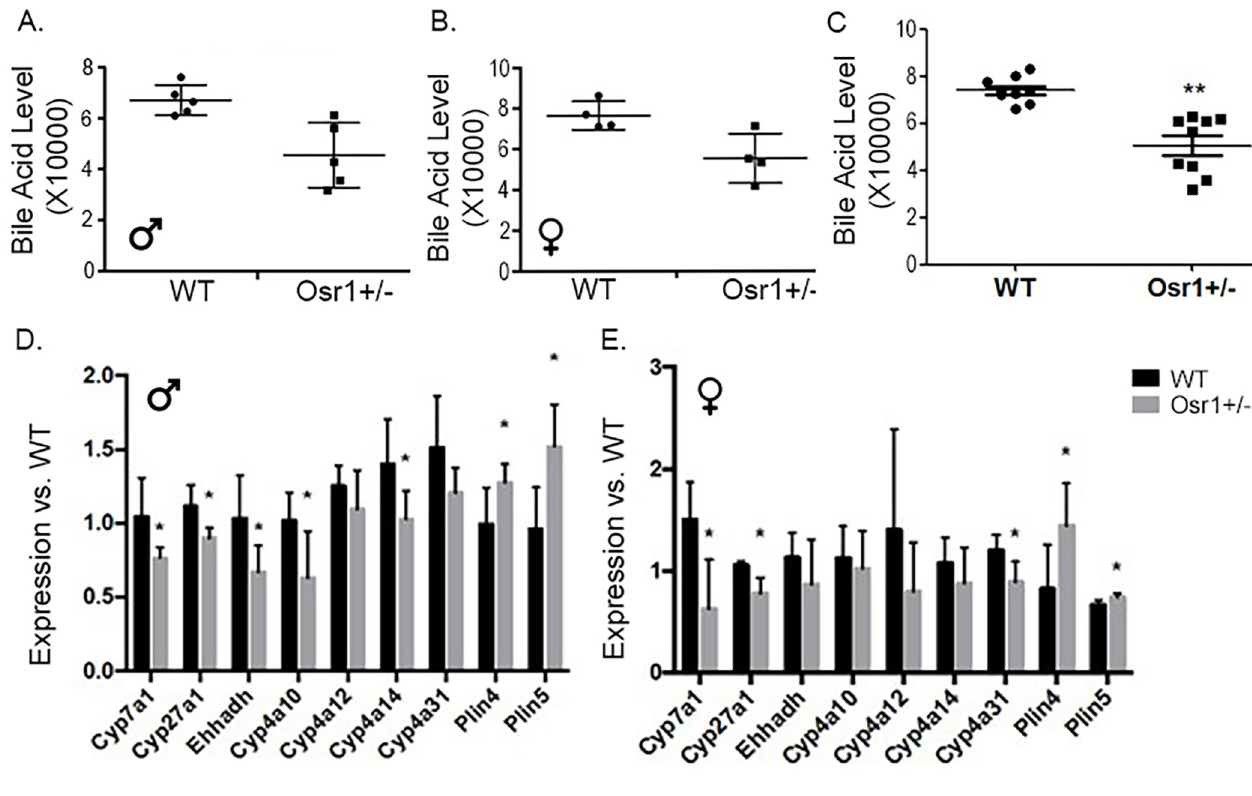
Fig 4. Osr1 heterozygous mice experienced decreased bile acid synthesis in the liver. (A). Osr1 male mice had a decreased trend of hepatic bile acid compared to WT mice. (B). Osr1 female mice had a decreased trend of hepatic bile acid compared to WT mice. (C). Combined results of Osr1 male and female mice show a decreased trend of hepatic bile acid compared to WT mice. (D) Osr1 heterozygous male mice had significantly decreased expression of Cyp7a1 , Cyp27a1 , Ehhadh , Cyp4a10 and Cyp4a14 compared to WT male mice. Plin4 and Plin5 were significantly increased in Osr1 male mice. (E). Cyp7a1 , Cyp27a1 , Ehhadh , and Cyp4a31 were significantly reduced in Osr1 knockdown female mice. Osr1 female mice had significantly increased gene expression of Plin4 and Plin5 . Data is presented as Mean ± SD, N = 5; � p <